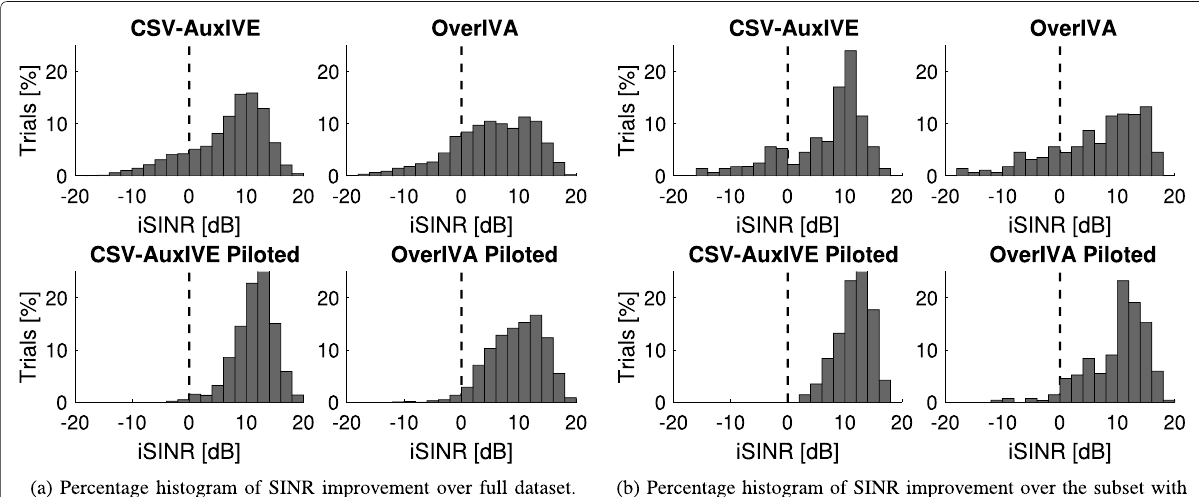
Fig. 6 Histograms of SINR improvement achieved by the variants of CSV-AuxIVE in the experiment of Section 4.3